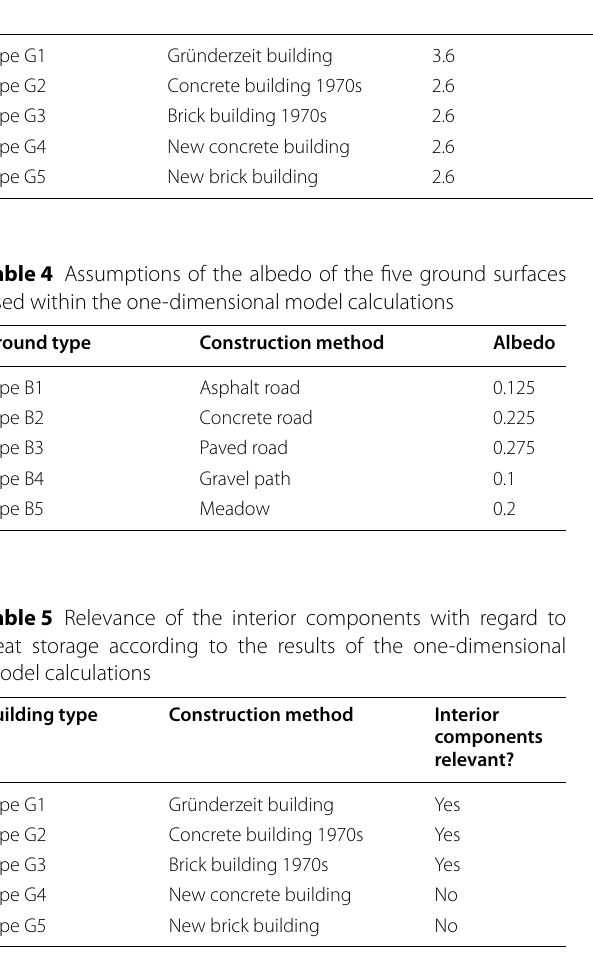
Table 3 Calculation parameters of the five building types used within the one-dimensional model calculations Building type